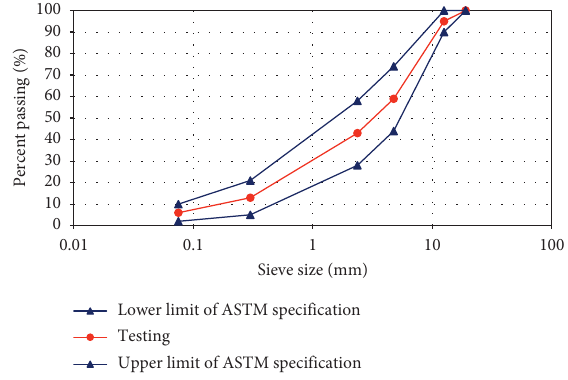
Figure 1: Aggregate gradation for sample production. Table 1: Physical characteristics of the bitumen.